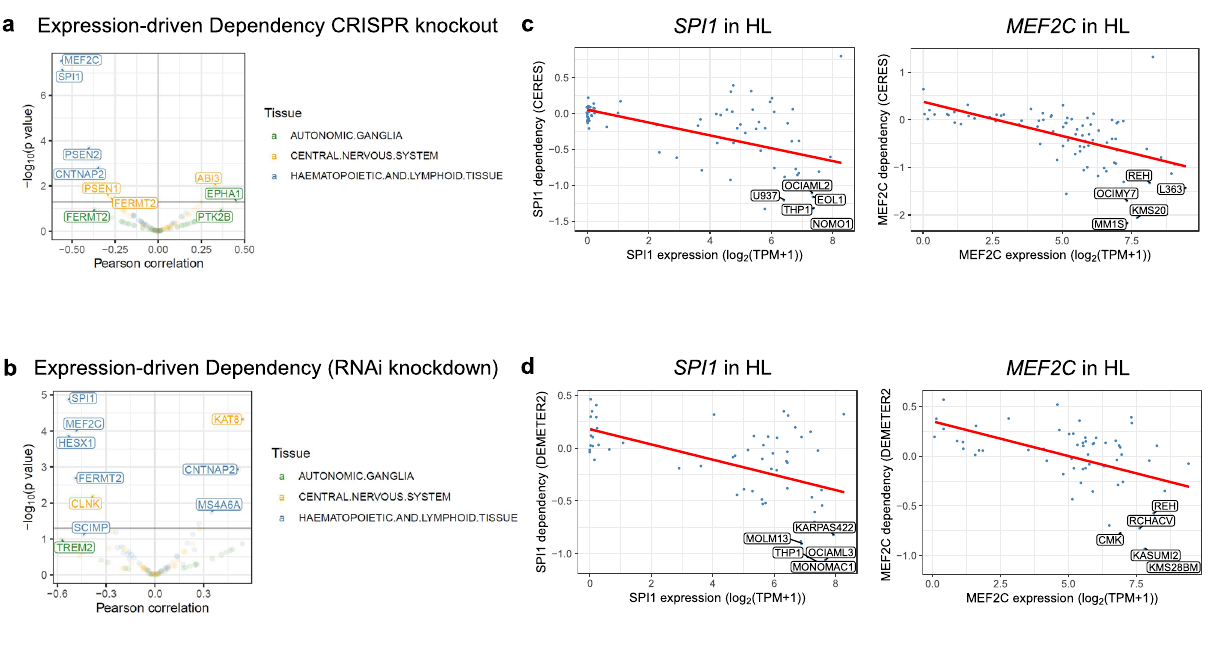
Figure 3. Expression-driven Dependency of AD Risk Genes. ( a ) A volcano plot showing expression-driven dependency of AD risk genes based on CRISPR knockout screen data. ( b ) A volcano plot showing expression- driven dependency of AD risk genes based on RNAi knockdown screen data. For ( a ) and ( b ), Pearson correlation coefficients were calculated for AD risk genes using a gene’s expression versus the dependency scores for three tissue types (color-coded) relevant to AD etiology: hematopoietic and lymphoid tissue (HL), central nervous system (CNS), and autonomic ganglia (AG). The correlation plots of the expression-driven dependency were shown for associations found in the HL cell lines, including ( c ) SPI1 and MEF2C expression with their respective CERES dependency scores, as well as ( d ) with their respective DEMETER2 dependency scores. The best-fitted regression lines are shown in red and the cell lines with the highest expression and dependency are further labeled in each